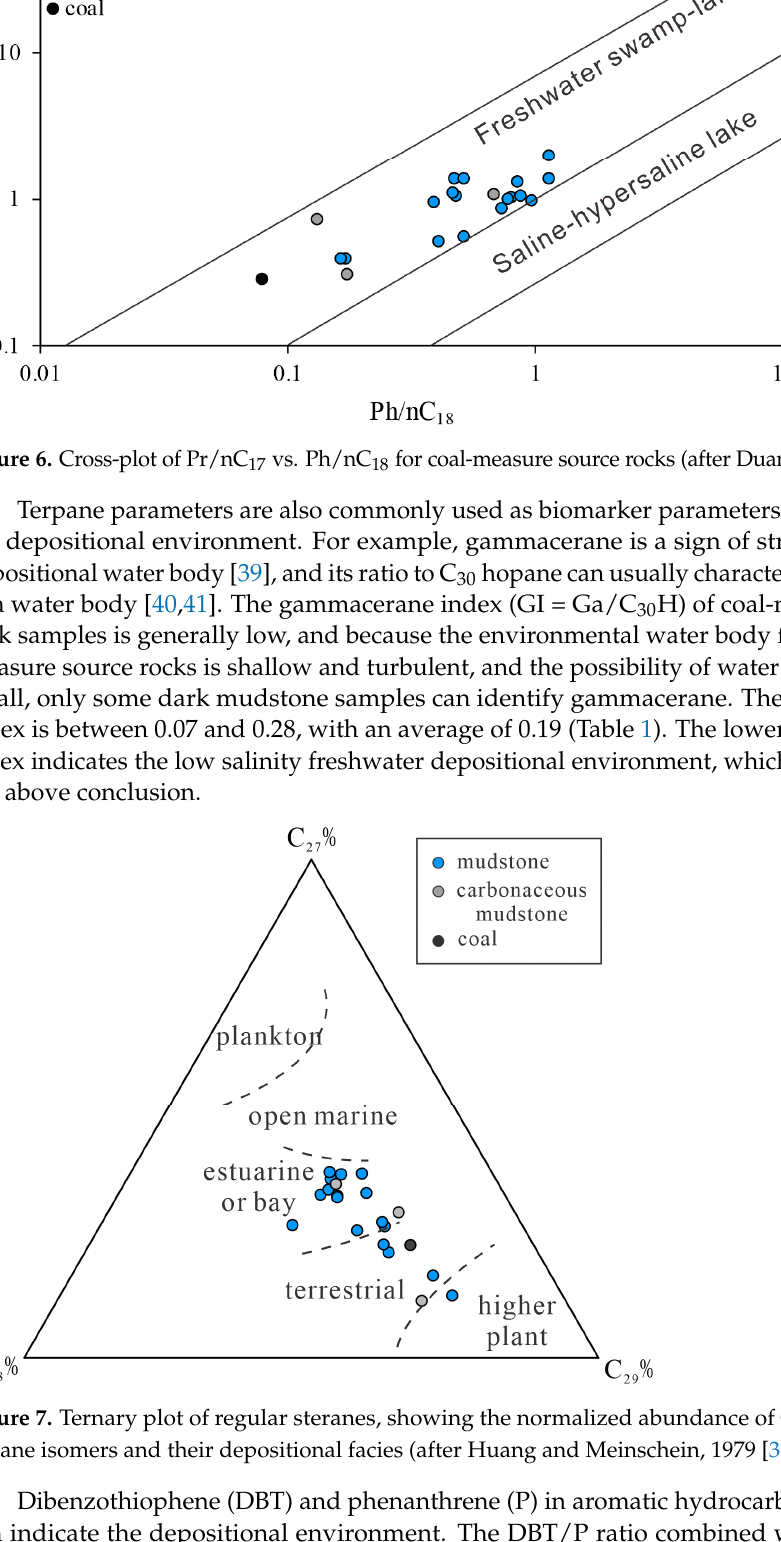
Figure 6. Cross ‐ plot of Pr/nC 17 vs. Ph/nC 18 for coal ‐ measure source rocks (after Duan et al., 2006 [36]).